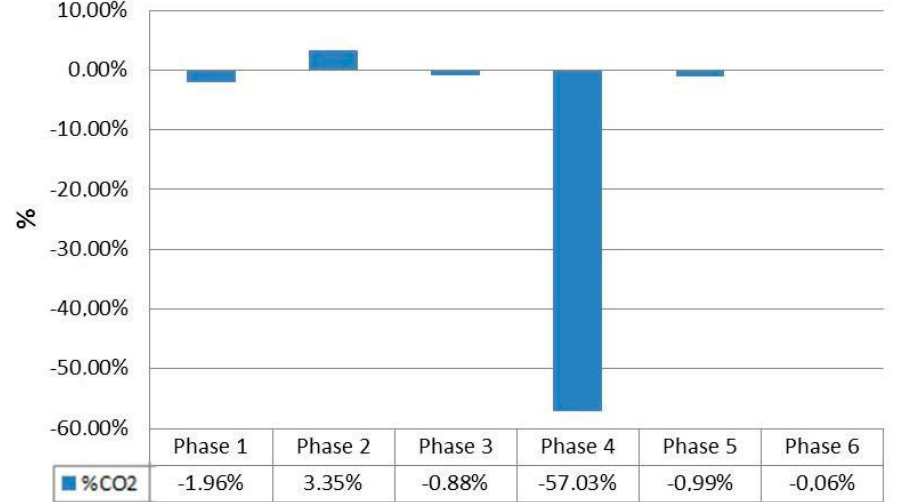
Figure 4. CO 2 emissions resulting from the difference between enzymatically ‐ produced protein hydrolysate from lupine grains and chemically ‐ produced protein hydrolysate from leather waste by industrial phase.